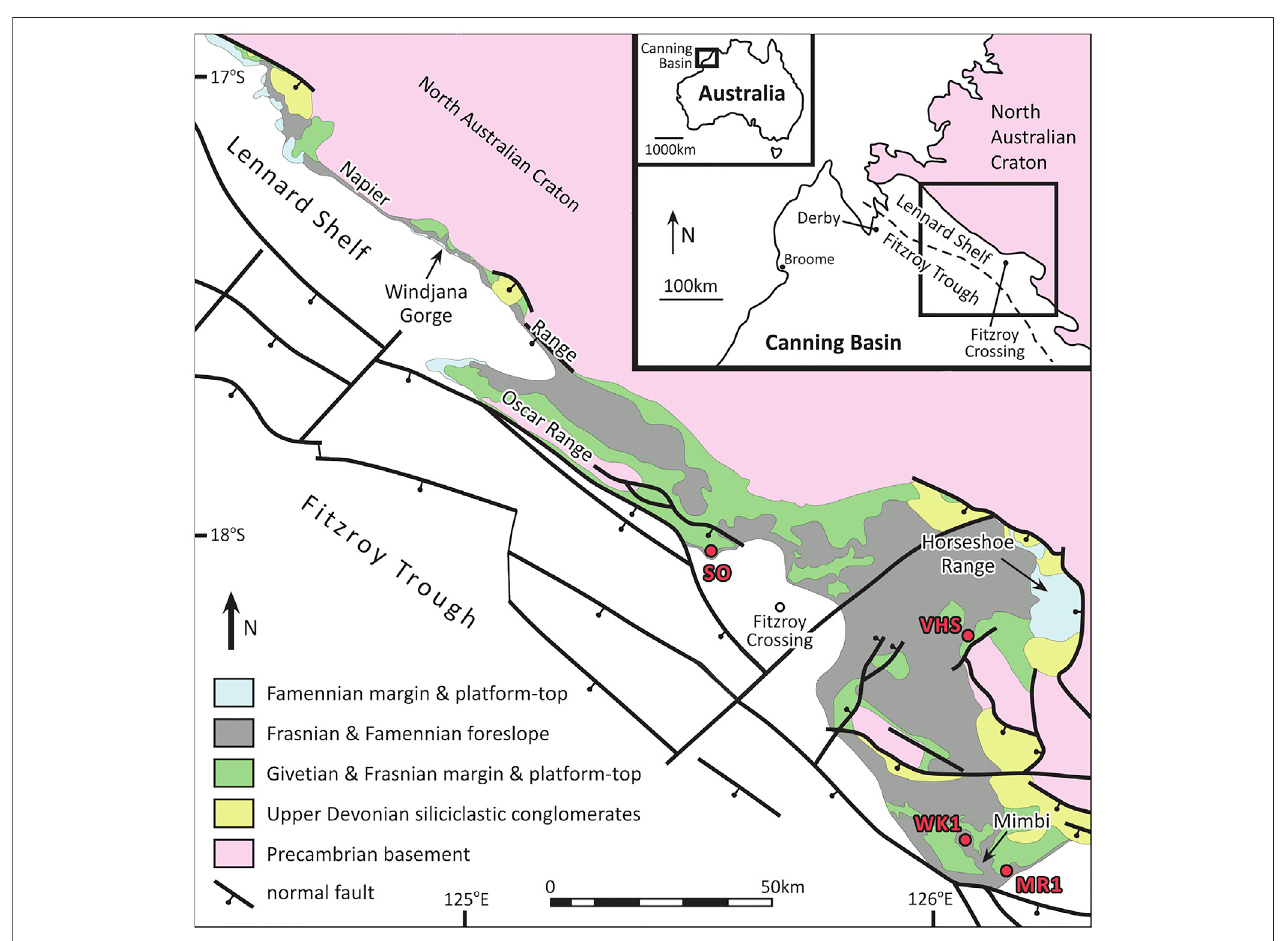
FIGURE 1 | Simpli fi ed geologic map of Lennard Shelf, Canning Basin. Simpli fi ed outcrop exposure and location maps for the Lennard Shelf, Canning Basin, Western Australia. Red labels indicate sites where paleomagnetic data was collected. SO (cid:1) South Oscars measured section; VHS (cid:1) Horse Spring measured section; WK1 (cid:1) Wade Knoll Winkie core; MR1 (cid:1) McWhae Ridge Winkie core. SO and VHS paleomagnetic data were analyzed and published in Hansma et al. (2015). Modi fi ed after Playton et al. (2016).